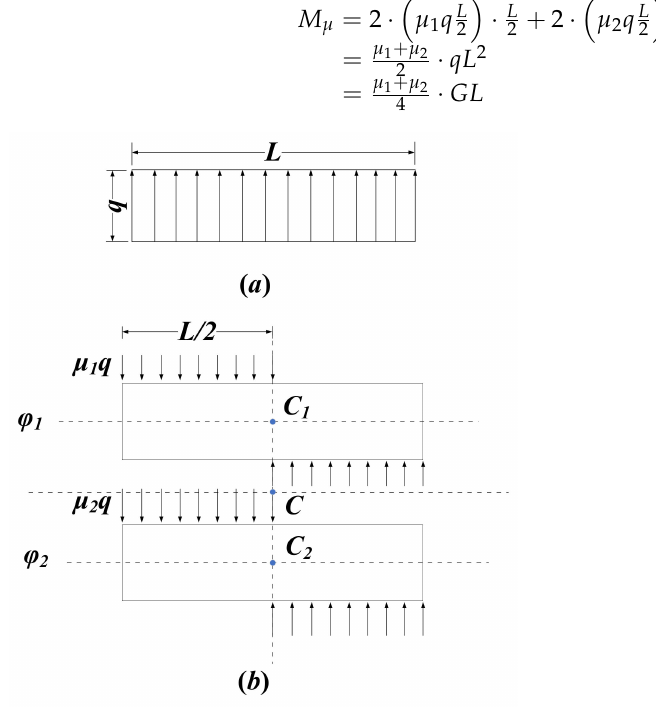
Figure 8. Track vehicle force analysis diagram: ( a ) longitudinal; ( b ) horizontal.